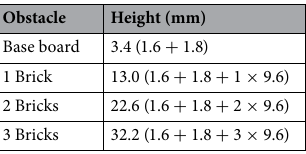
Table 1. Heights of the four obstacles. The studs on the bricks and the base board had a height of 1.8 mm, the plane part of the base board had a height of 1.6 mm. The bricks without the studs had a height of 9.6 mm.